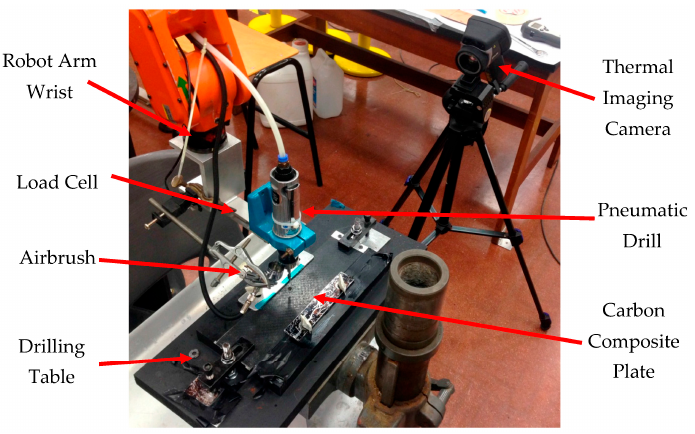
Figure 4. Experimental apparatus.